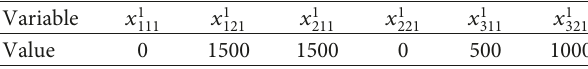
Table 14: Transportation costs need to be paid for the goods transported to final destinations D1 and